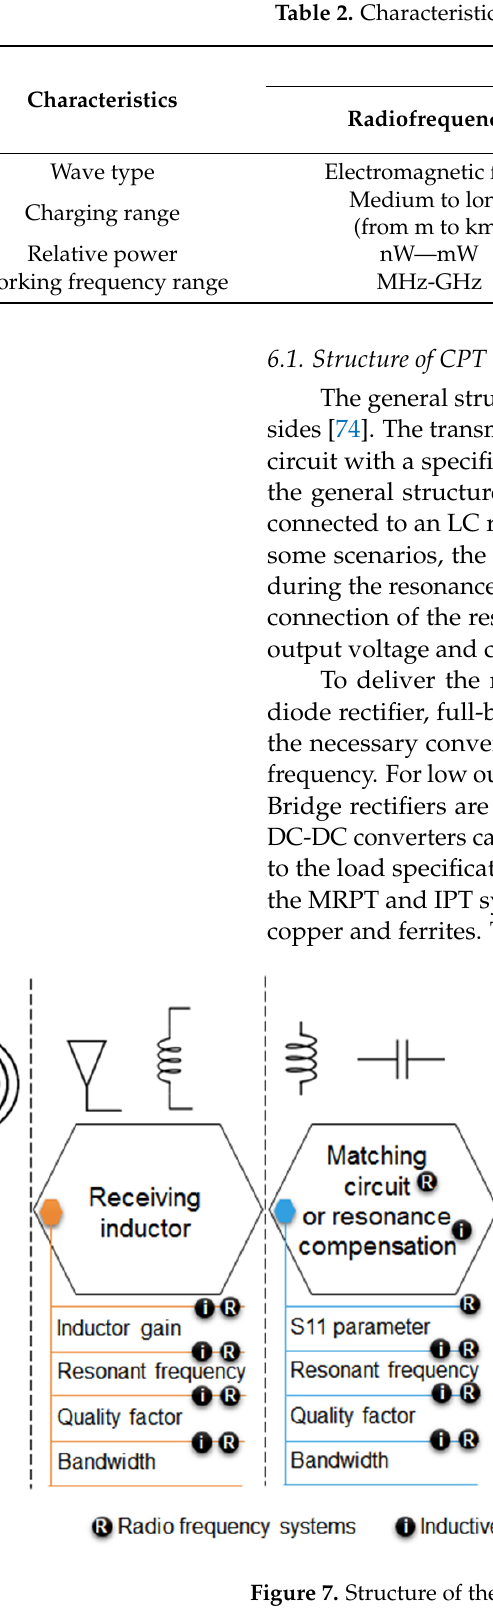
Figure 7. Structure of the receiving side in wireless charging systems.